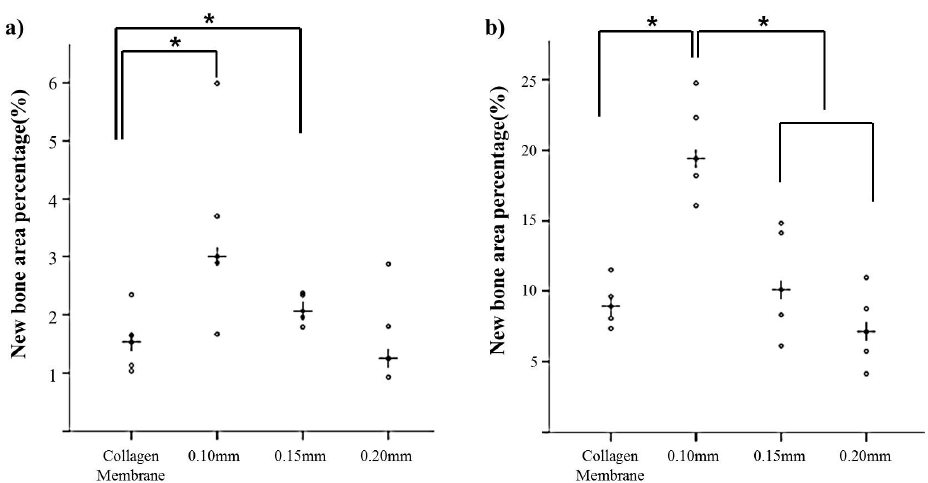
Figure 7. Scatter plot and median (the cross) representing ( a ) 2 weeks after surgery new bone area